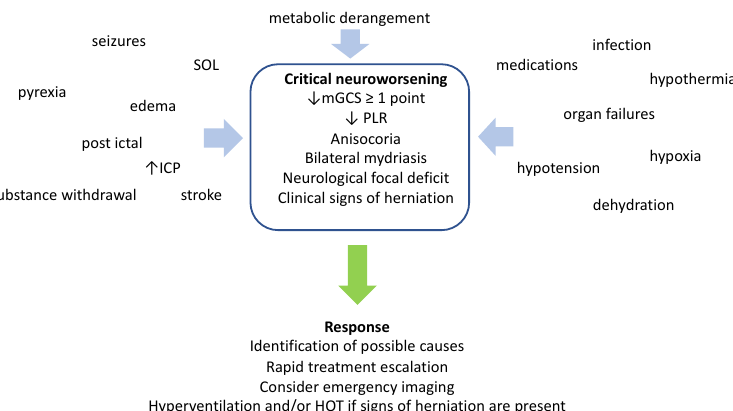
Figure 2. Definition, causes, and management of critical neuroworsening. mGCS: motor Glasgow Coma Score; PLR: pupillary light reflex; SOL: space-occupying lesion; ICP: intracranial pressure; HOT: hyperosmolar therapy.